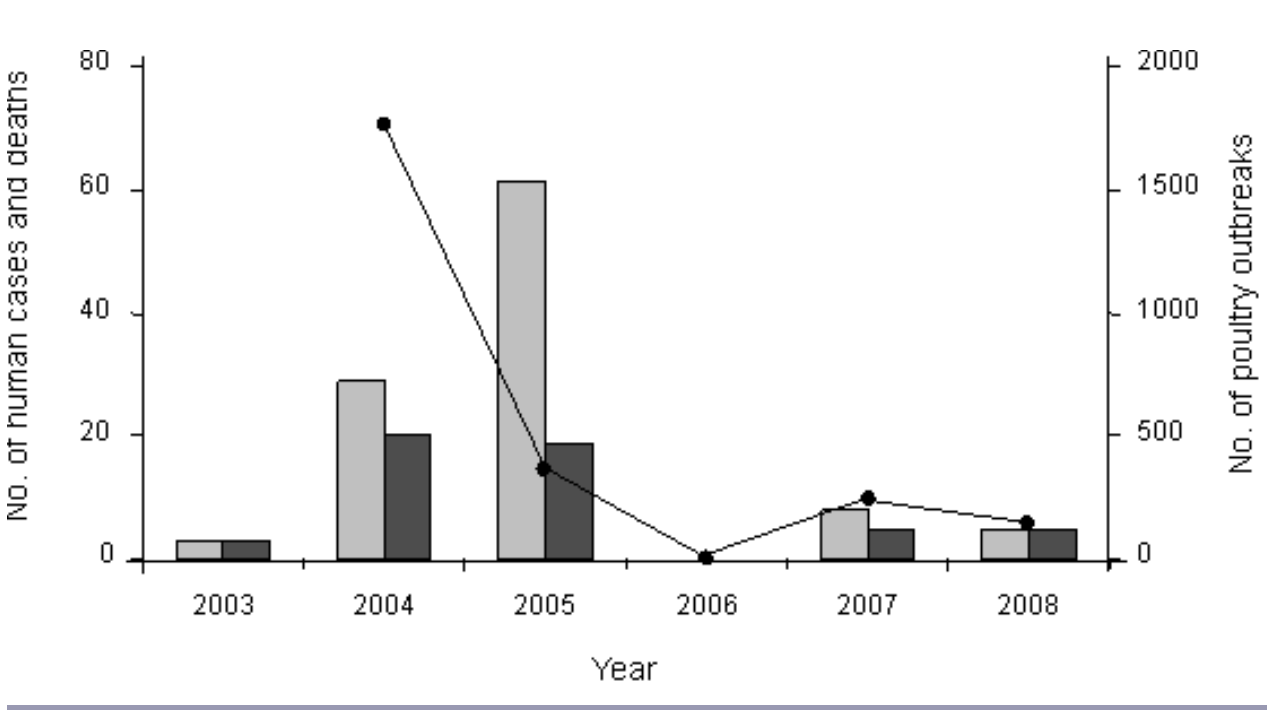
Fig. 3 . The number of reported human cases (in grey) of avian influenza H5N1 and resulting deaths (in black) in Vietnam from 2003 to 2008 (World Animal Health Organisation 2008), and the number of reported outbreaks of avian influenza H5N1 in poultry (solid line) from 2004 to 2008 (World Animal Health Organisation